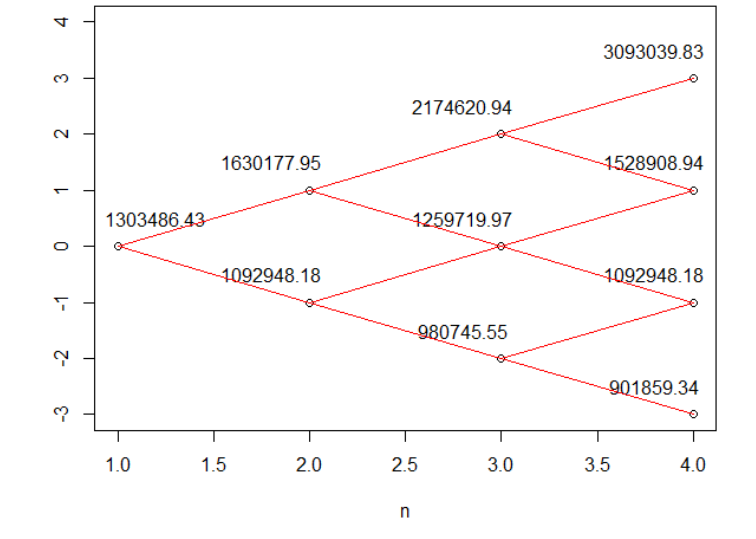
Figure 4. Tree 2 option to